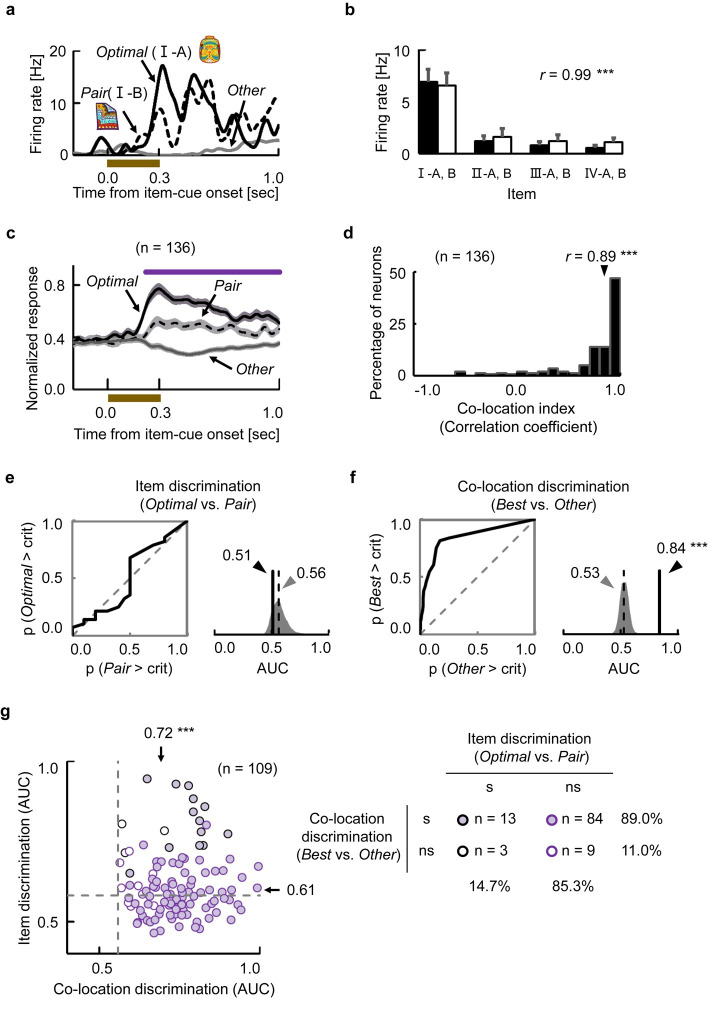
Representation of the retrieved memory during the item-cue period.(a) Example of an item-selective neuron with the co-location effect. Black lines indicate SDFs in trials with the Optimal and its Pair items (i.e., best co-location items) of the neuron. Gray line indicates averaged response in the other trials (Other). Brown bar, presentation of the item cue. (b) Mean discharge rates and SEM of the same neuron during the item-cue period for each item. Black bars, set A. White bars, set B. r, co-location index. ***P < 0.0001, permutation test, 2-tailed. (c) Population-averaged response of item-selective neurons (n = 136). SDFs in trials with the best co-location items (i.e., Optimal and Pair) and other items. Shading, SEM. Purple line, time duration indicating a significant (P < 0.01, t-test, 2-tailed) difference between pair and other. (d) Distributions of co-location indices for item-selective neurons (n = 136). r, median value. ***P < 0.0001, Wilcoxon’s signed-rank test, 2-tailed. (e) Response discriminability between the optimal and its paired items of the same example neuron in Fig 2A. (Left) ROC curve. (Right) Solid vertical line, AUC value of the example neuron. Gray area and dashed vertical line, distribution of simulated AUC values and its median. (f) Response discriminability between best and other co-locations of the same neuron. ***P < 0.0001, permutation test, 1-tailed. (g) Two-dimensional scatter plots of AUC values between the item (ordinate) and co-location (abscissa) discriminations for item-selective neurons with high co-location index (r > 0.6; n = 109). Each circle indicates one neuron. Arrow, median of real AUC values for each discrimination. Dashed line, median of simulation AUC values for each discrimination. ***P < 0.0001, Wilcoxon’s signed-rank test, 2-tailed. s, significant, P < 0.05 for each neuron, permutation test, one-tailed. Source data are available in S1 Data. AUC, area under curve; ns, nonsignificant; ROC, receiver operating characteristic; SDF, spike density function.